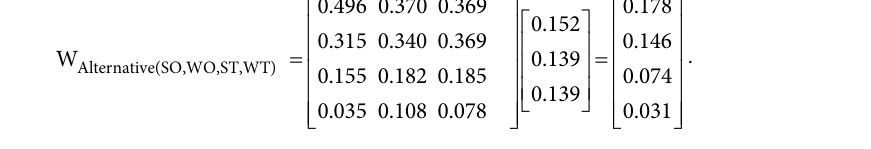
Table 14. Results of alternative strategies